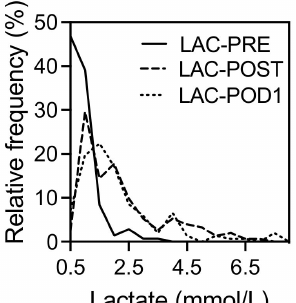
Figure 1. Perioperative distribution of lactate concentration in 152 patients who underwent liver resection. LAC-PRE, lactate level before liver resection; LAC-POST, lactate after liver resection on day 0; LAC-POD1, lactate on day one after liver